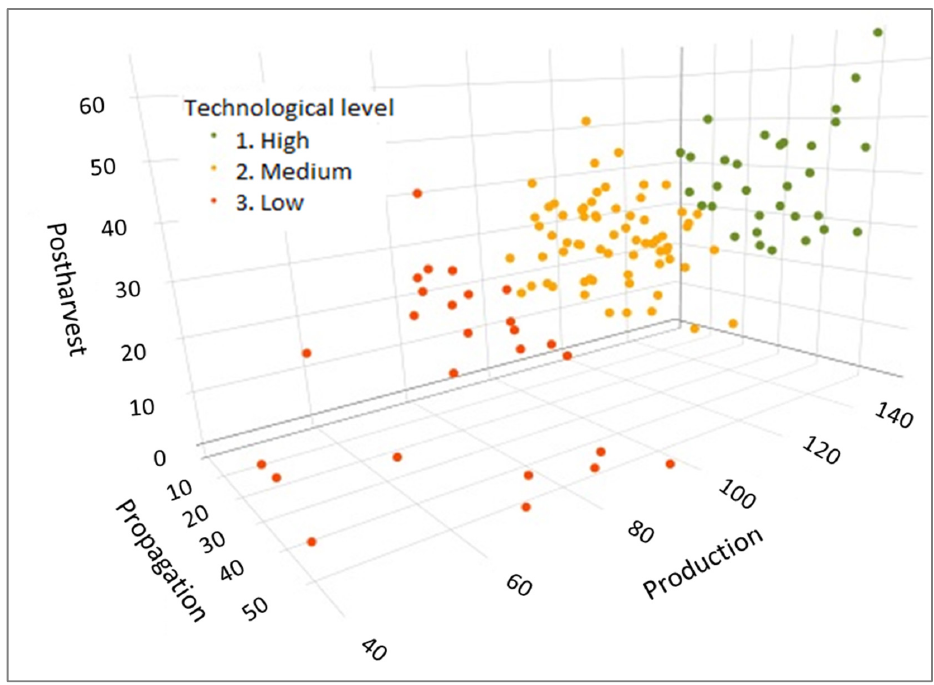
Figure 4. Grouping of producers according to technological level and stage in the avocado value chain in Colombia.